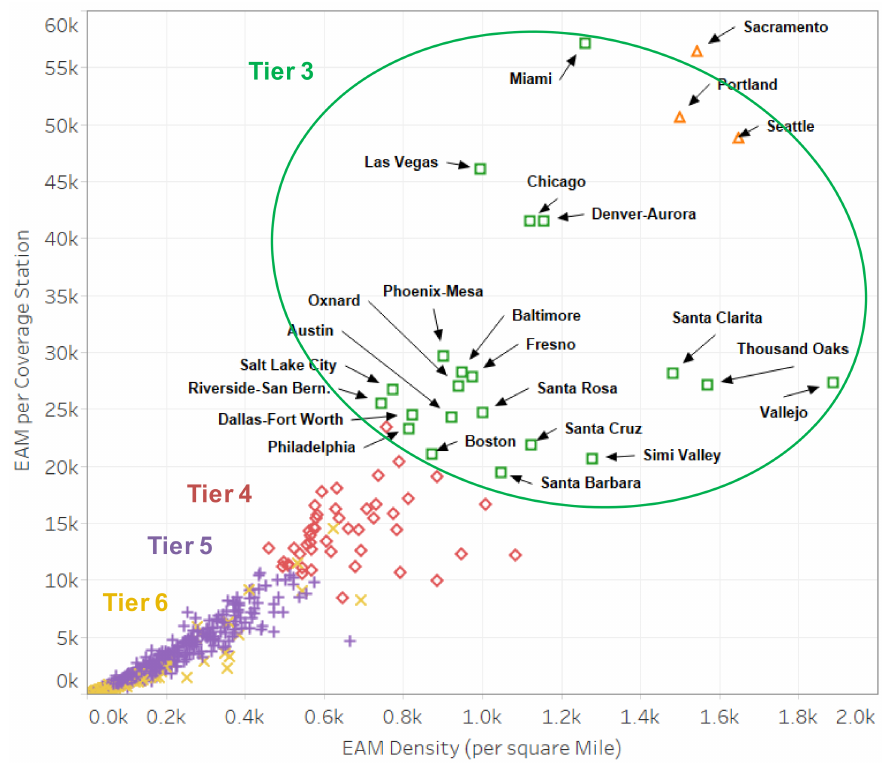
Figure 3. Prioritization of urban markets by EAM density and EAM per coverage